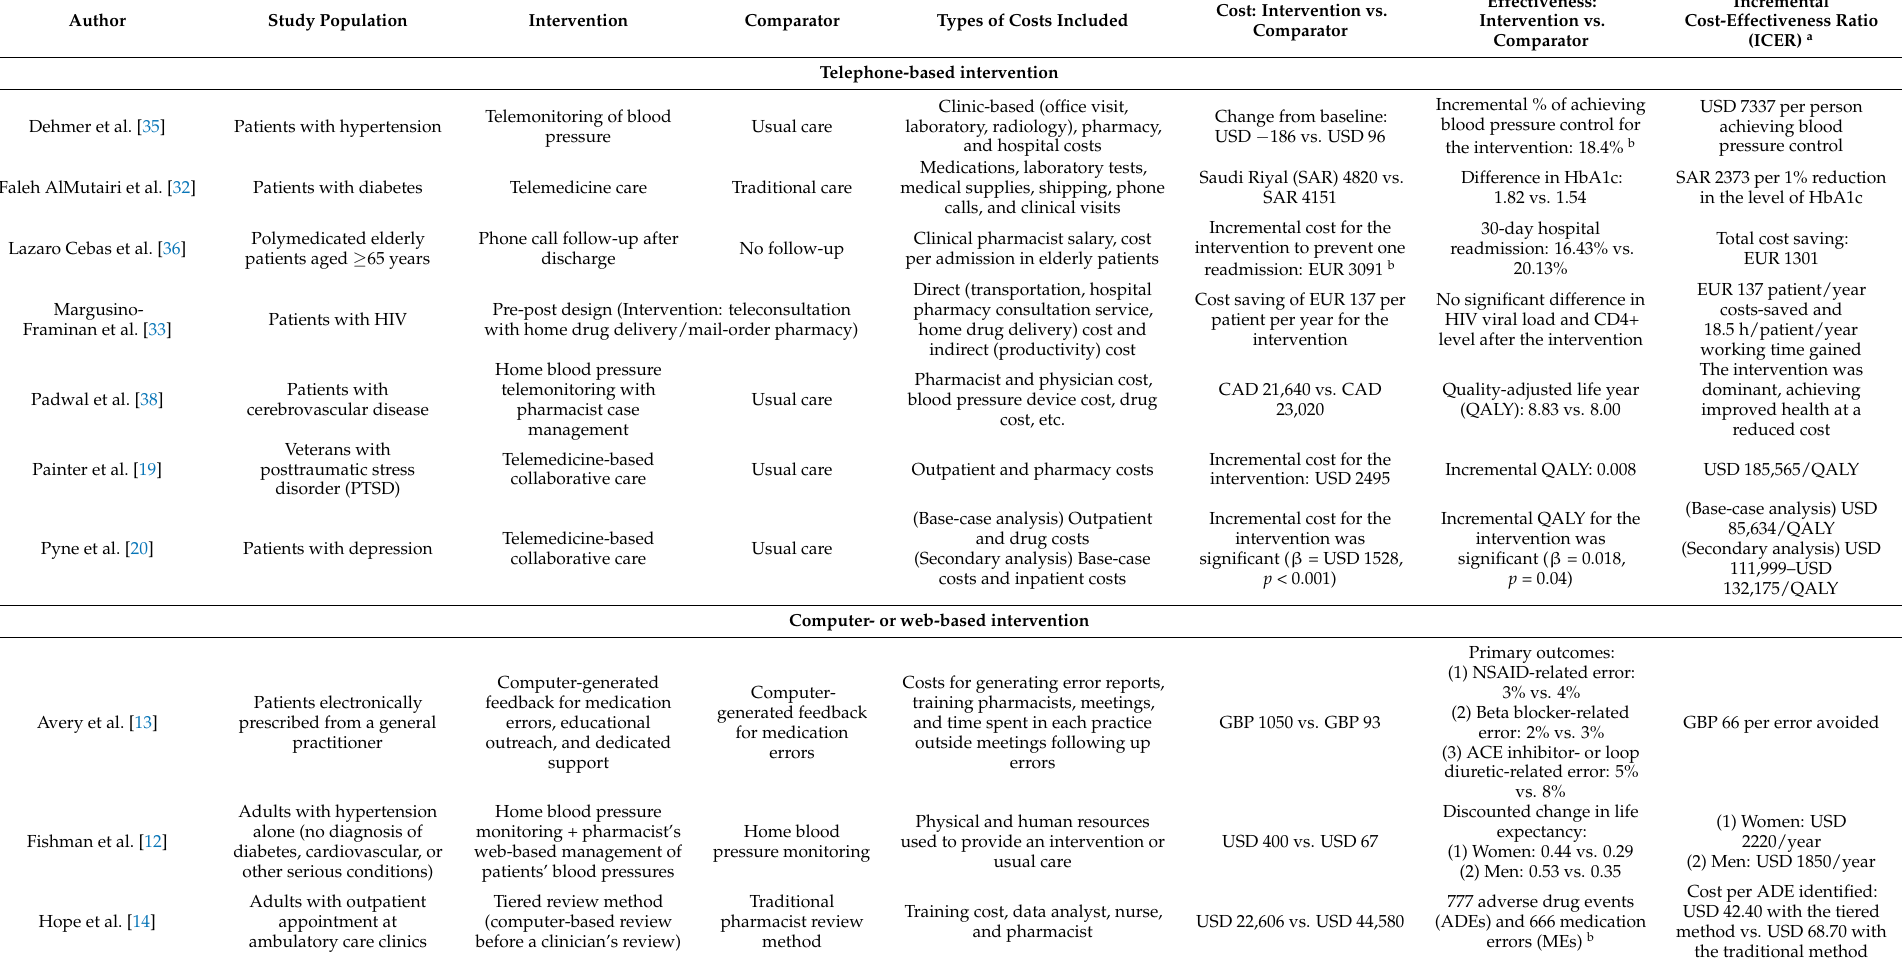
Table 3. Summary of the included cost-effectiveness analysis